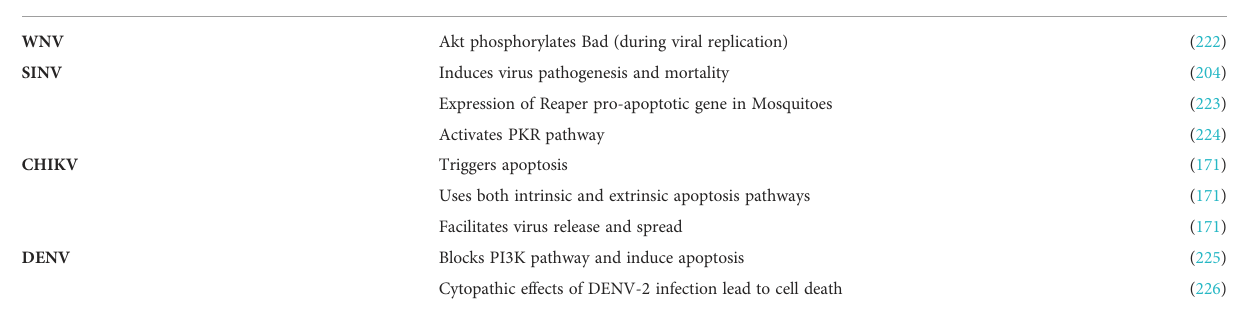
TABLE 6 Arboviruses and apoptosis